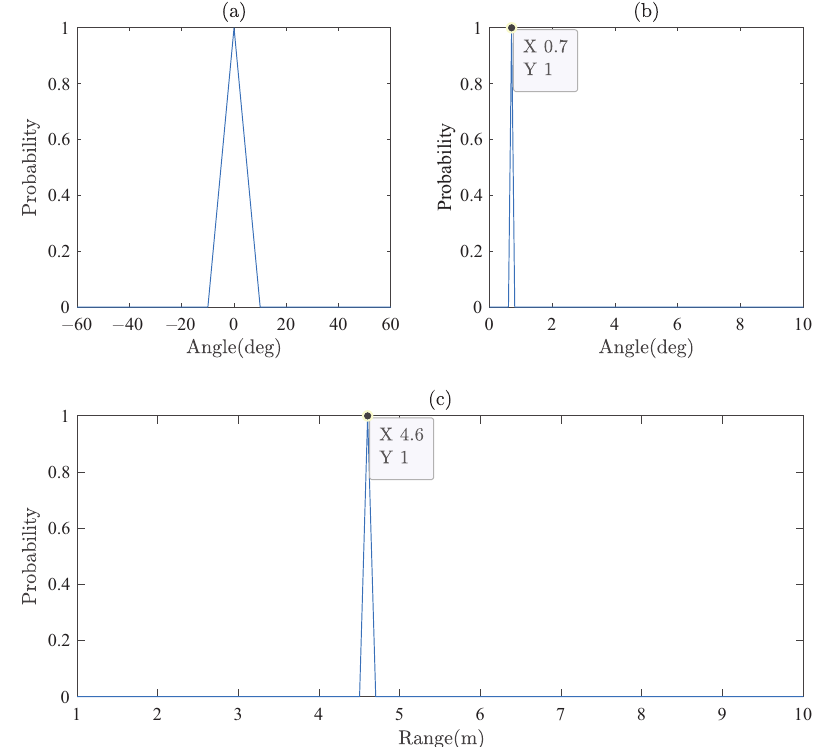
Figure 15. DOA and range estimation result of Scenario 1.